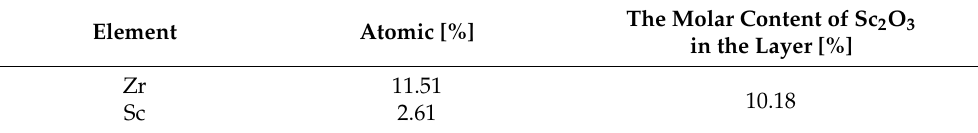
Table 2. Average chemical composition determined by EDS analysis and calculated molar content of Sc 2 O 3 in the layer (Figure 2). The synthesis temperature: 600 °C. Total gas pressure: 10 5 Pa. The molar content of Sc(tmhd) 3 in the gas mixture: 28%.